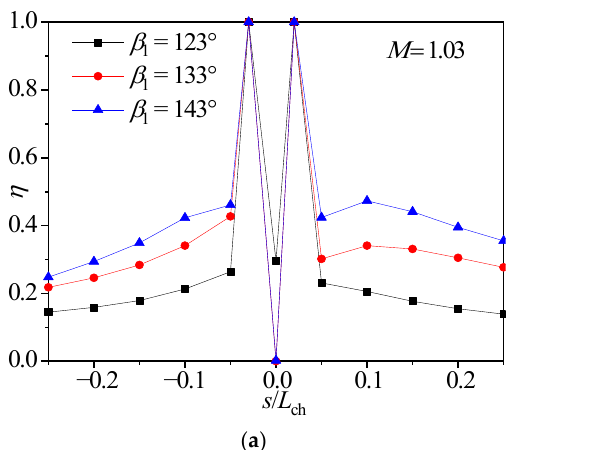
Figure 5. Distribution of adiabatic film cooling effectiveness at the leading edge. edge.